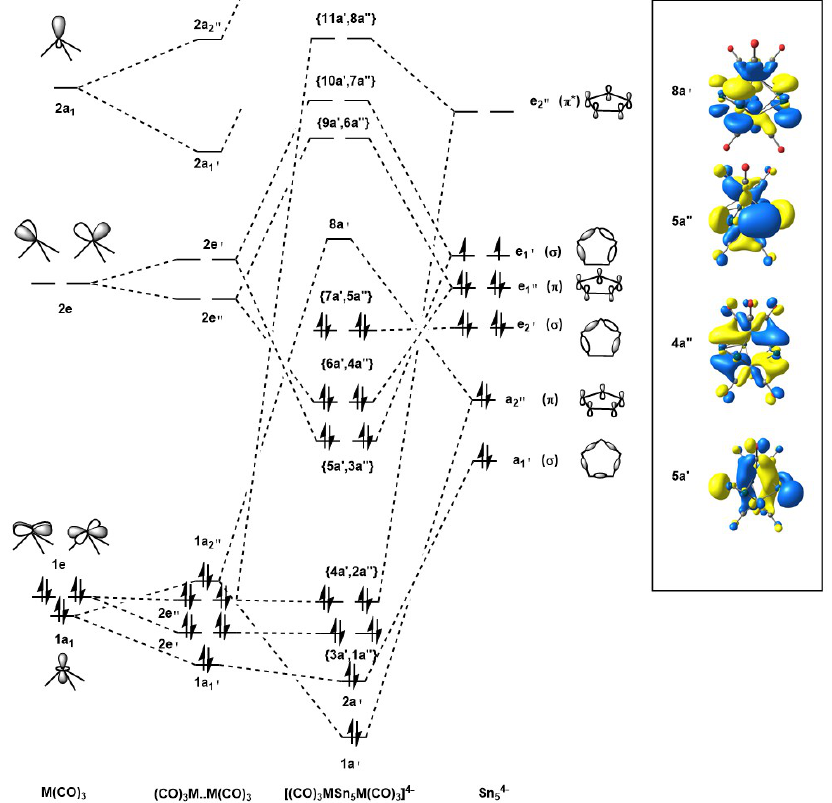
Figure 4. Schematic molecular orbital diagram for [(CO) the M(CO) , M (CO) and Sn fragments are labelled according to C 3 v , D 3 h and D 5 h point symmetry, 3 2 6 5 respectively. The cluster itself has only C S point